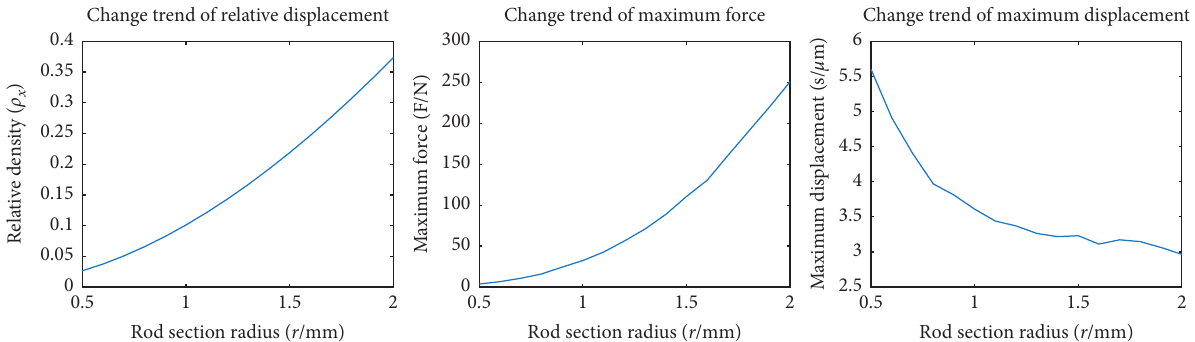
Figure 10: Variation trend of parameters of structure unit with section radius of rod.